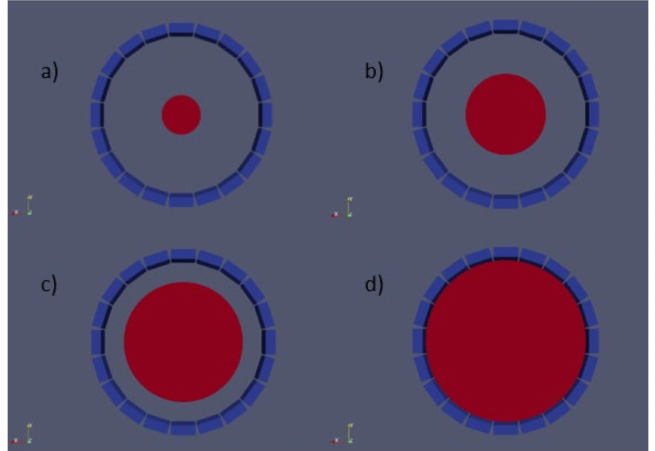
Figure 3. Simulation of a water cylinder with different radii and the same activity source. It can be appreciated the detector system and the phantoms used. ( a – d ) 40, 80, 120, and 160 mm